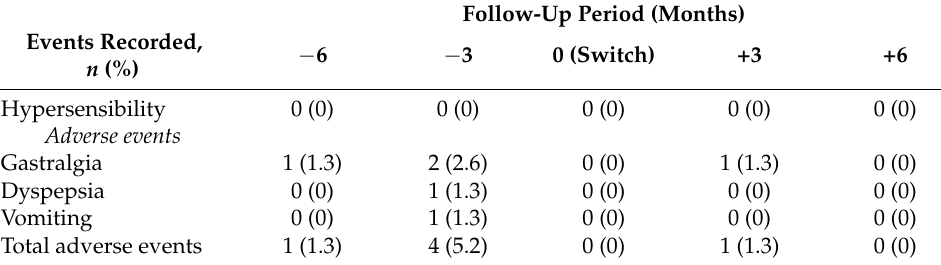
Table 5. Proportion of patients experiencing side effects over the 12-month study period. Follow-Up Period